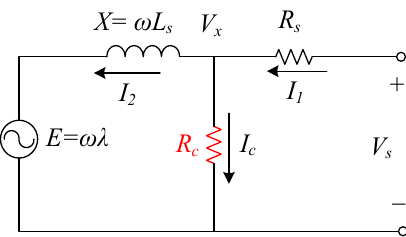
Figure 5. Per-phase ECM with predictable core loss of PMSMs [9].